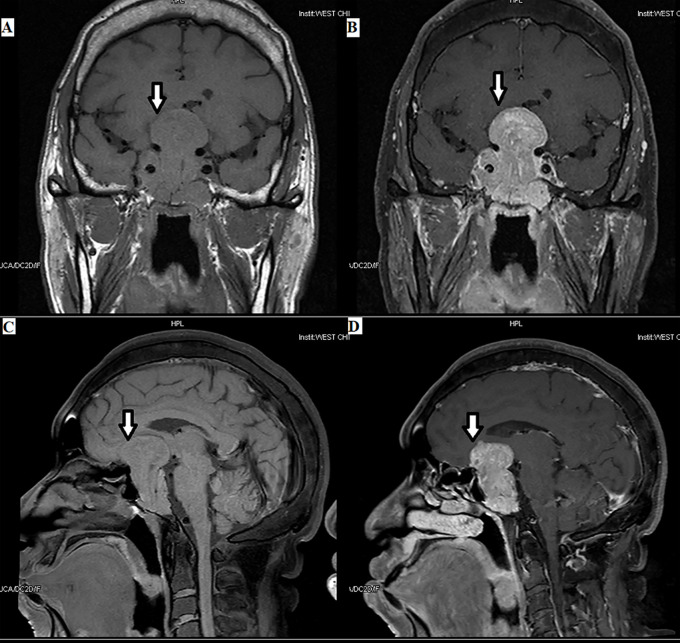
Plurihormonal TSH PitNET [growth hormone (GH) and TSH]: the tumor can be seen in the optic chiasm, hypothalamus, and saddle area, with a size of 3.8×5.6×3.5 cm, as indicated by the arrows.